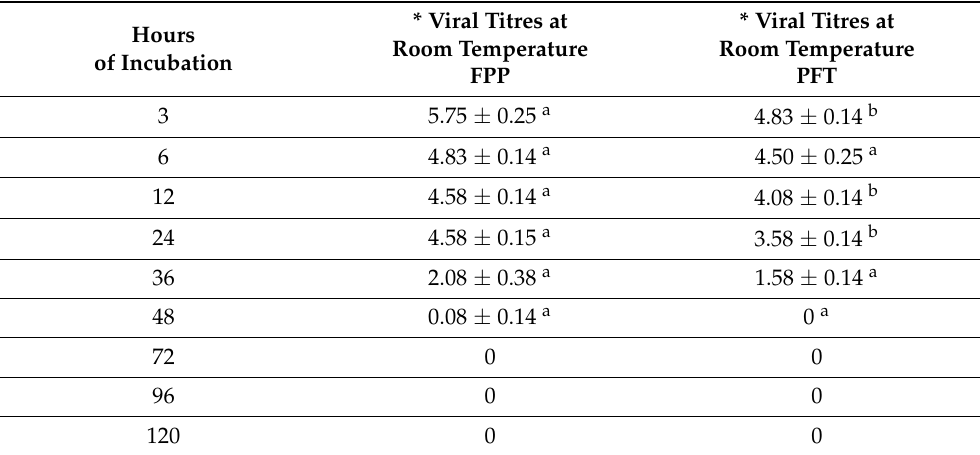
Table 2. Stability over the time of feline coronavirus on FPP and PFT at refrigeration conditions. * Viral Titres Hours at Refrigeration Condition of Incubation FPP